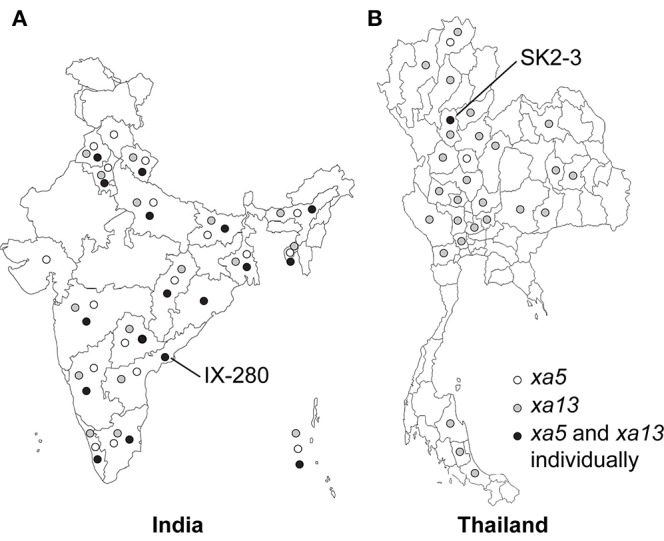
Distribution of Xoo strains compatible with rice varieties IRBB5 (xa5, white), IRBB13 (xa13, gray), or both IRBB5 and IRBB13 (xa5 and xa13 individually, black) in (A) India and (B) Thailand.